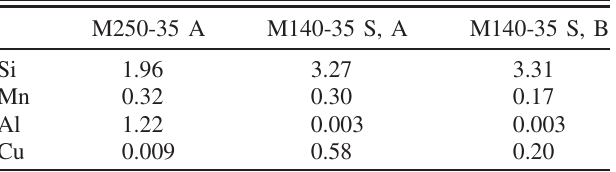
TABLE VIII. Chemical composition in % of M250-35 A and M140-35 S from supplier A and B.